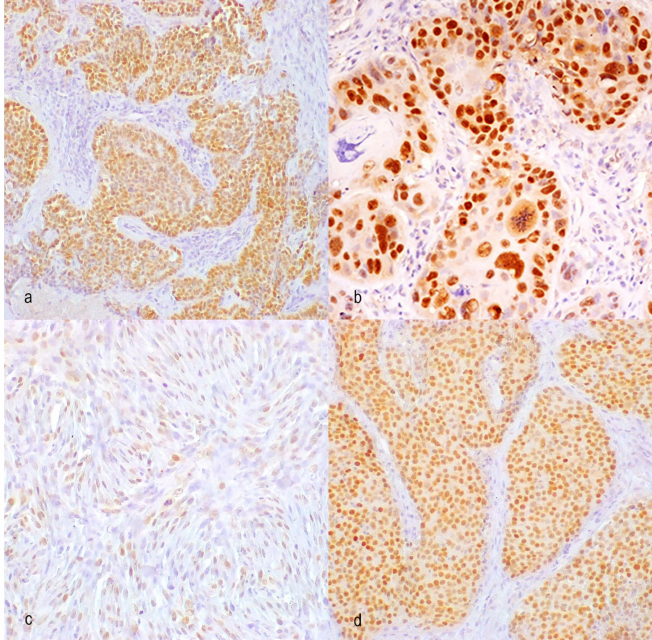
Figure 1. Immunohistochemistry of dog anti-p53 antibody. ( a ) Mammary carcinoma; the majority of the nuclei were immunolabeled (4 × ). ( b ) Squamous cell carcinoma; the nuclei were strongly and diffusely immune-positive (20 × ). ( c ) Soft tissue sarcoma; about half the cells had an immune-positive nucleus (10 × ). ( d ) Amelanotic melanoma; all nuclei of tumor were immunolabeled (10 × ). Table 1. Tissue, tumor type, histological grade, immunohistochemical positivity, and TP53 mutation results for each p53-positive case (15/176) are reported. NE, non-evaluable; WT, wild-type; SCC, squamous cell carcinoma; MCT, mast cell tumor; STS, soft tissue